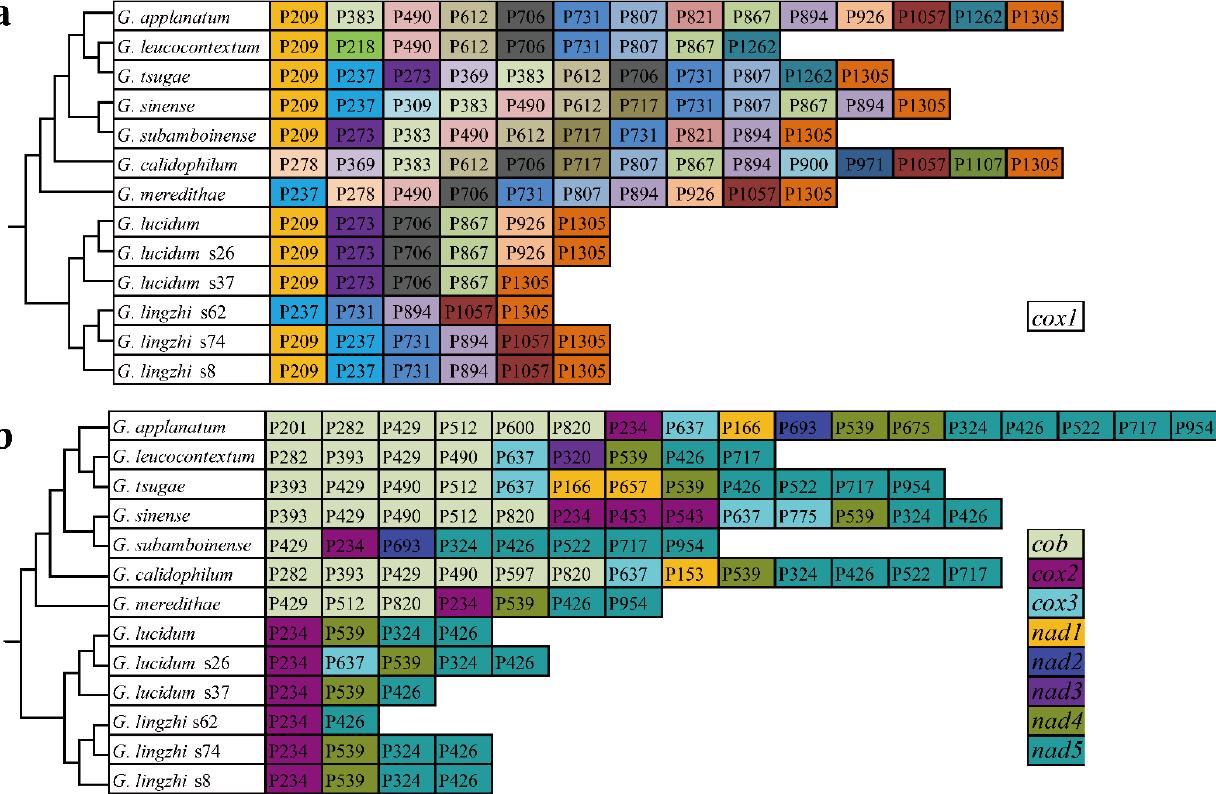
Figure 5. Position class (Pcl) information of cox1 ( a ) and other core PCGs ( b ) of the 13 Ganoderma species. Pcls (orthologous introns) were named according to the insert sites (nt) in aligned reference genes (MH252535). The phylogenetic positions of the 13 Ganoderma species were established using the Bayesian inference (BI) method and maximum likelihood (ML) method based on a combined mitochondrial gene set.